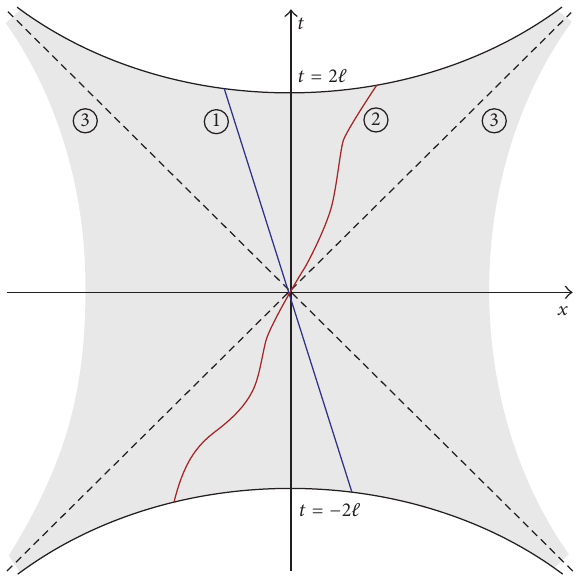
Figure 1: Conformal representation of de Sitter space-time. Note that the “observer” space-time is the interior of the Cayley-Klein absolute 𝑡 2 − ⃗𝑥 2 = 4ℓ 2